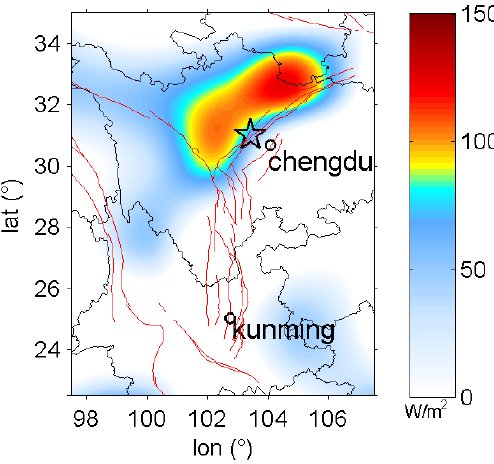
Fig. 1. Accumulative monthly OLR variations over Sichuan- Yunnan region in 2007 (epicenter is marked with star, active faults with red lines).